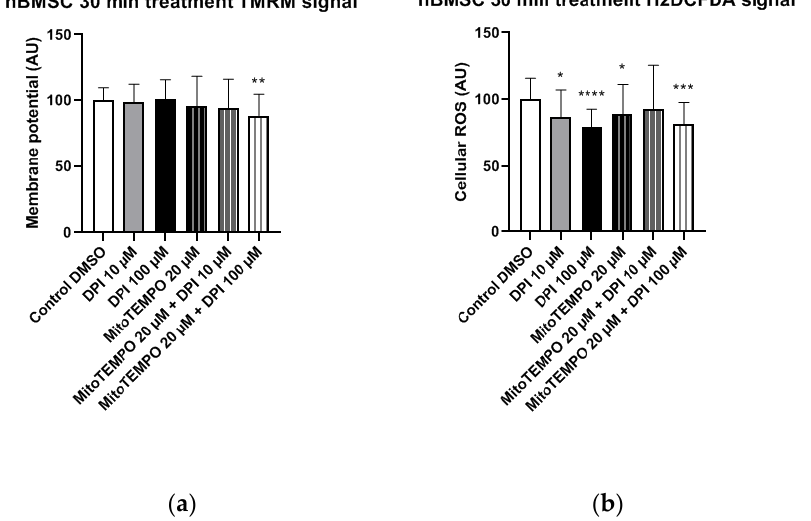
Figure 5. Mitochondrial membrane potential and cellular ROS levels 30 min after the treatment of human amniotic membrane mesenchymal stromal cells (hAMSCs) with diphenyleneiodonium chloride (DPI) and MitoTEMPO. ( a ) Changes in the mitochondrial membrane potential are not present. ( b ) Changes of the cellular ROS levels are not present. Data is represented as means + SD (error bars) ( n = 24; each point was obtained by analyzing 2–4 single cells. p > 0.05; one-way ANOVA followed by multiple comparison post-hoc Fisher’s LSD test. There was no significant differences.